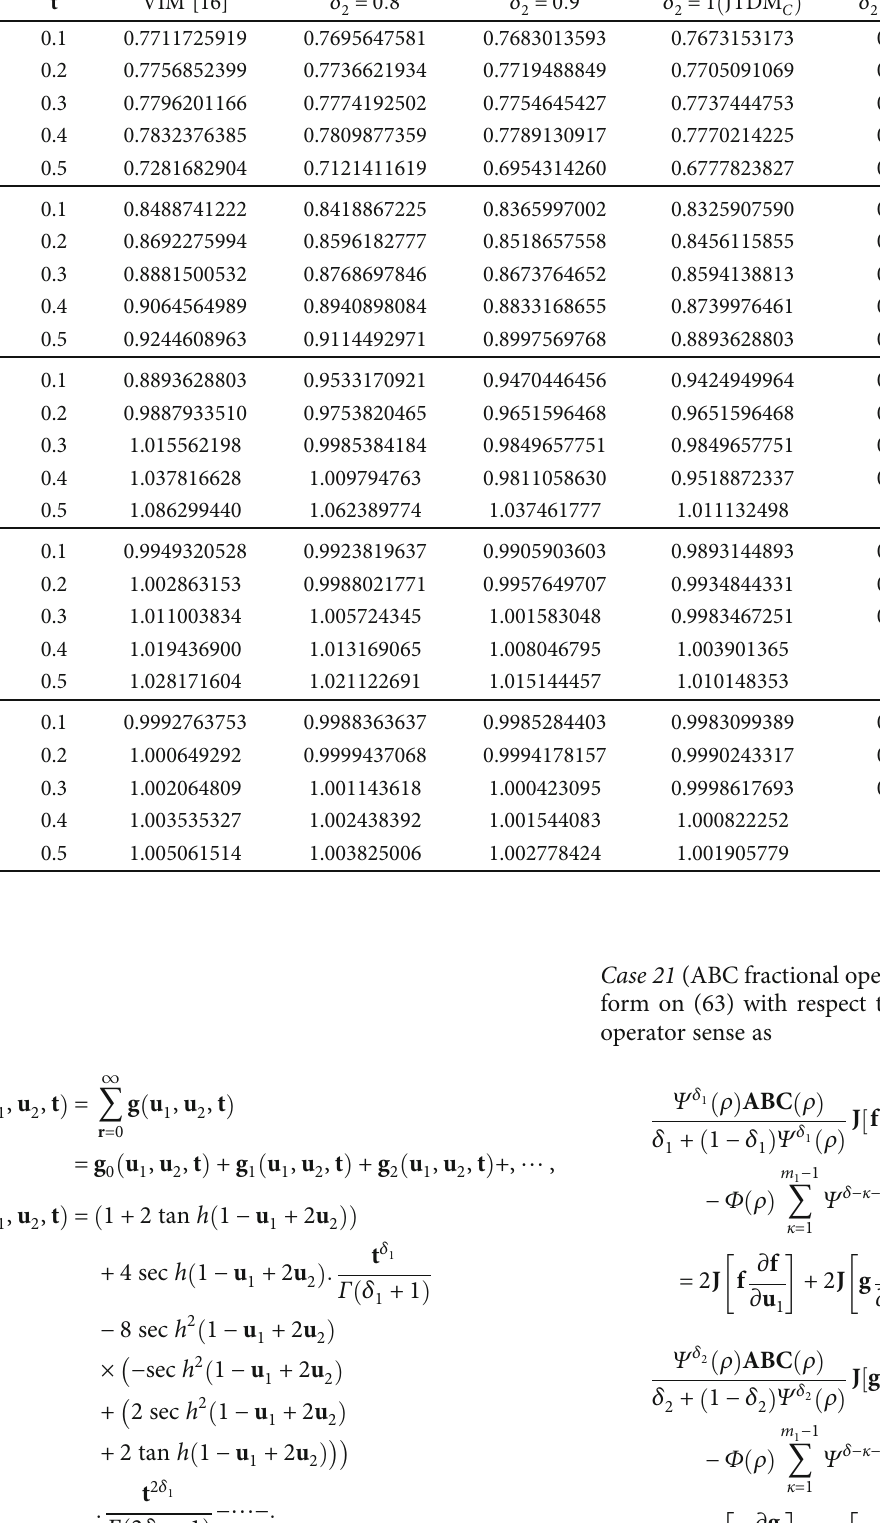
JTDM , u , t Þ of Example 16 for multiple fractional orders considering di ff erent values C and ABC solutions of g ð u 1 2